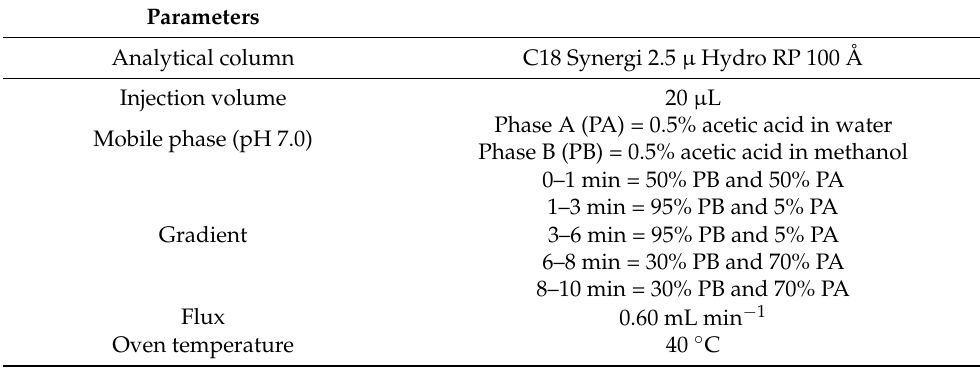
Table 2. Chromatographic conditions used for quantification of